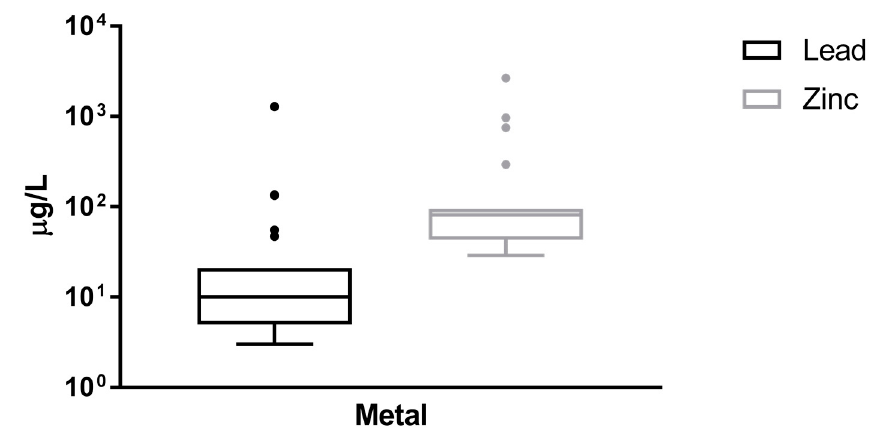
Figure 3. Metal concentrations measured in positive samples from 2016 sampling. Parameters of box plot shown are 25th, 50th, and 75th percentiles with whiskers extending to 5th and 95th percentiles.